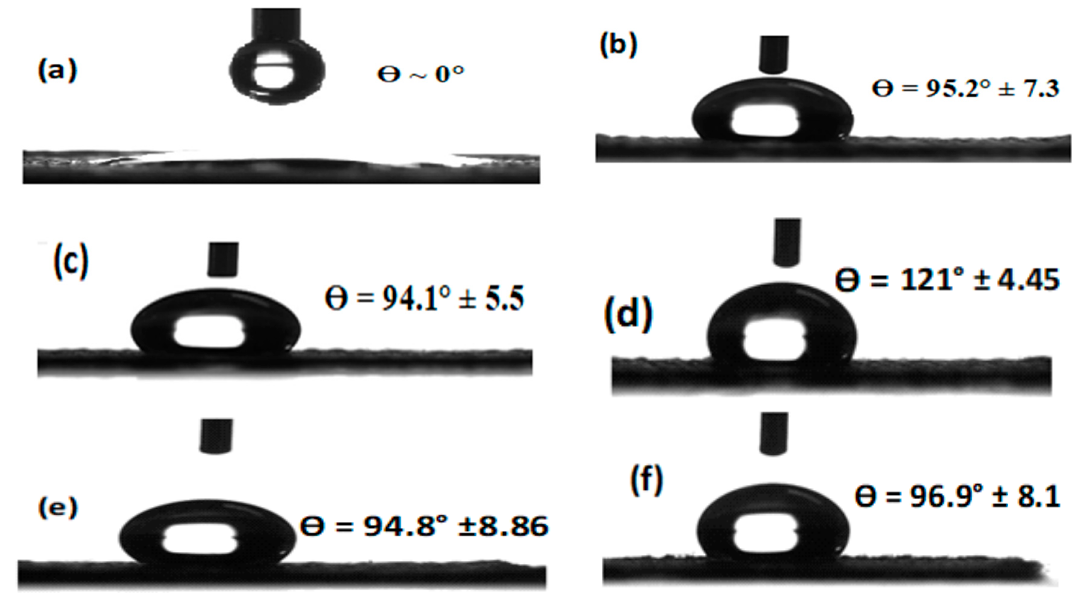
Figure 5. Contact angle of the samples. ( a ) Uncoated, ( b ) F1, ( c ) F2, ( d ) F3, ( e ) F4, and ( f ) (F5).